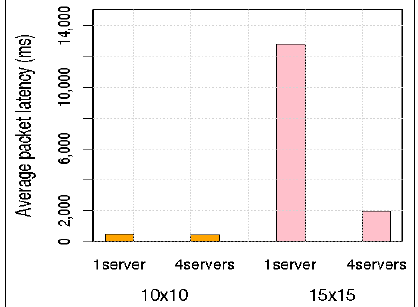
Figure 12. Occpancy data latency in a large network.